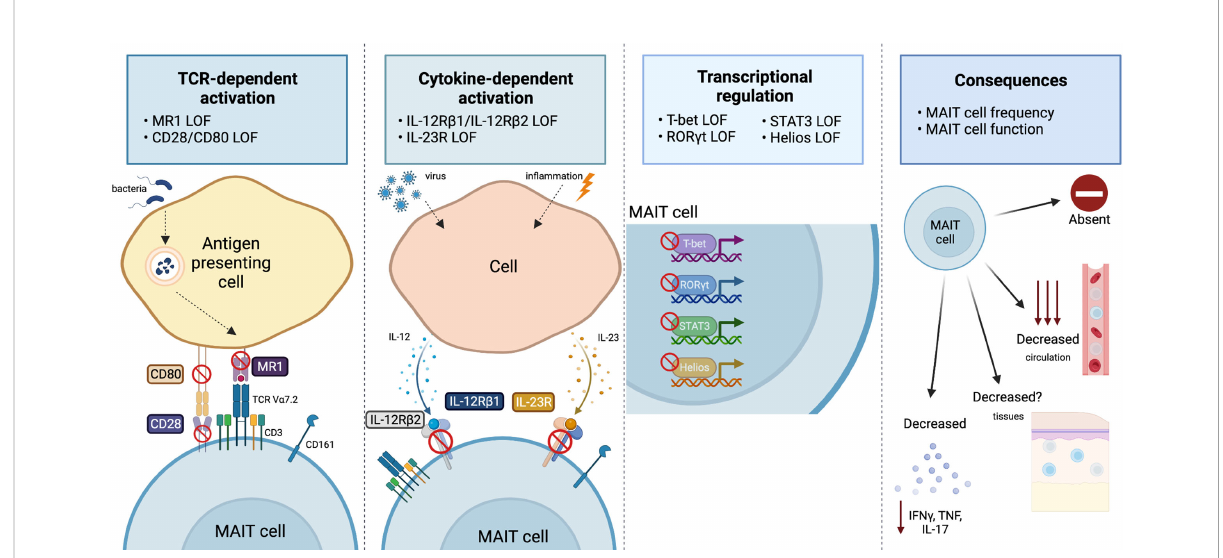
FIGURE 1 Overview of the range and consequences of MAIT cell activation and signaling pathways disrupted by IEI. MAIT cells can be stimulated via TCR- dependent activation, where microbial-derived vitamin B metabolites are presented on MR1 and recognized by the MAIT cell TCR V a 7.2. Disruptions to MR1 or costimulatory molecules (CD28/CD80) has been shown to impact the MAIT cell compartment. MAIT cells are also activated by viral or in fl ammatory conditions in which cells produce IL-12 or IL-23 in response. Cases in which IL-12R b 1, IL-12R b 2, or IL-23R are de fi cient alters the MAIT cells compartment. The transcription factors T-bet, ROR g T, STAT3 and Helios all play a vital role for MAIT cell development and/or effector function, and cases in which they are de fi cient report alterations to the MAIT cell compartment. Ultimately, all these pathway disruptions can cause varying consequences to the MAIT cell compartment, that includes: an absence or reduction in MAIT cells in circulation (it is unknown whether this is also the case at tissue sites) or a reduction in pro-in fl ammatory cytokine production (IFN g , TNF, or IL-17). Figure created with